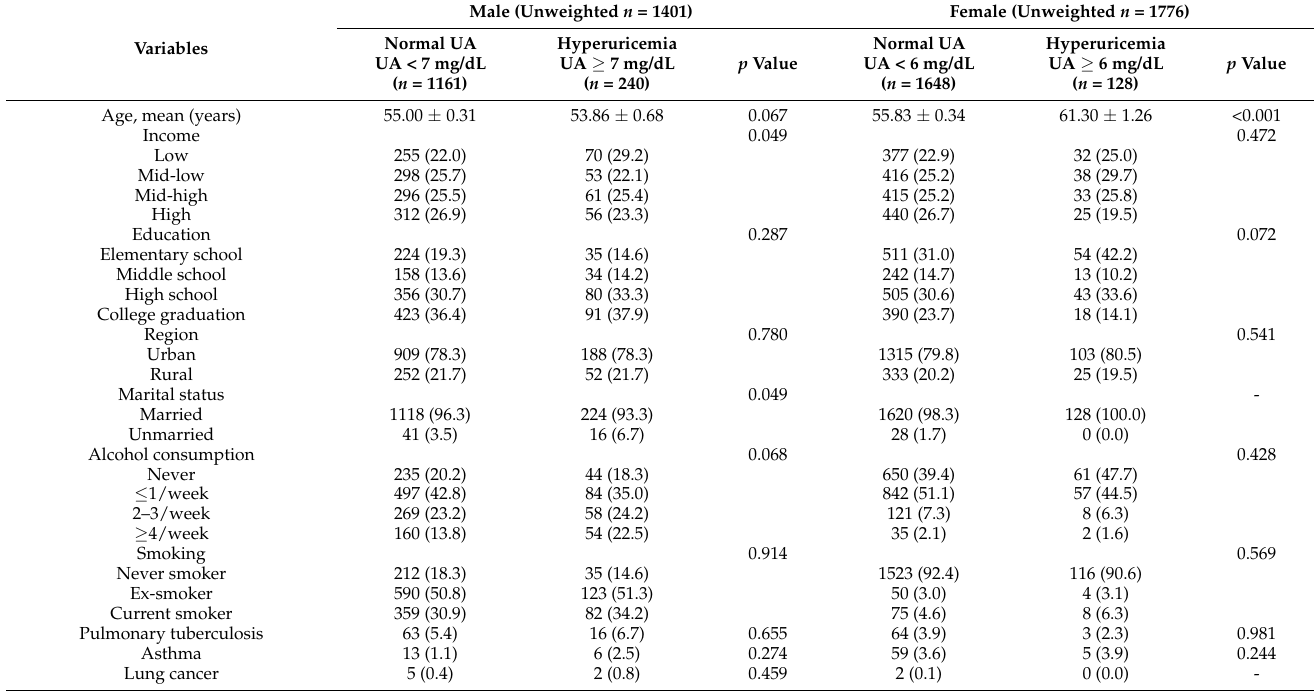
Table 1. Clinical and demographic characteristics of participants with hyperuricemia and with normal uric acid levels.